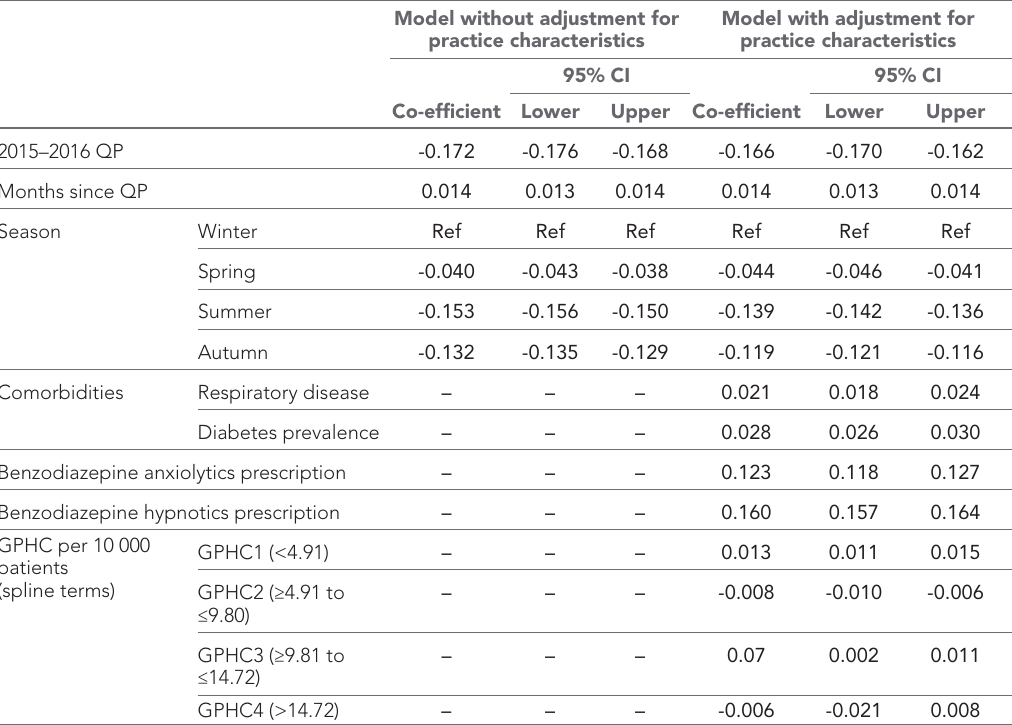
Table 2 Association between QP and antibiotic prescribing, N = 6251